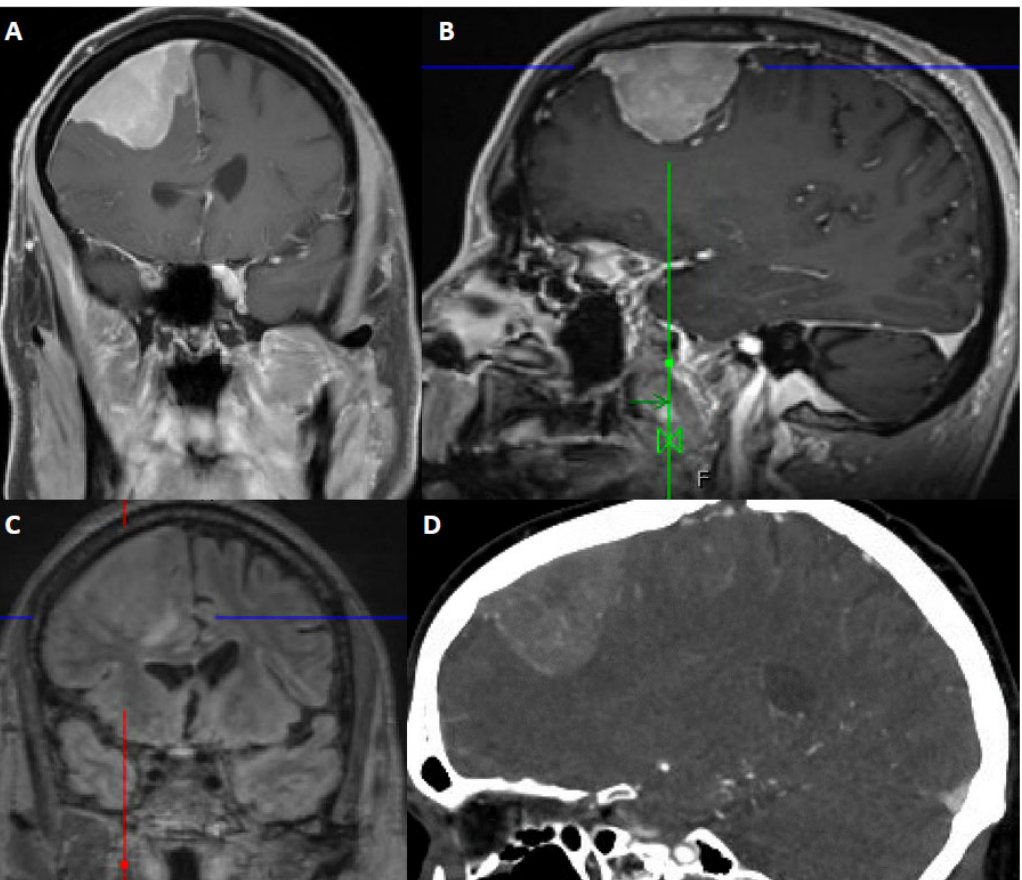
Figure 2. 67-year-old male presented with seizure and fall. After resection, pathology showed atypical meningioma, WHO grade 2. Molecular markers: TERT promoter wild type, positive for loss of chromosome 1p, 6, 14, 22, Y, segmental loss at 9p (haploinsufficiency of CDKN2A/B ). Patient underwent right middle meningeal artery embolization preoperatively. ( A ) Coronal contrast-enhanced T1-weighted image shows an avidly contrast-enhancing dural-based mass, dural thickening and enhancement, a slightly multilobular border, and moderate mass effect. ( B ) Sagittal contrast-enhanced Magnetization Prepared-RApid Gradient Echo (MPRAGE) shows a reactive dural tail. ( C ) Coronal 3D fluid attenuated inversion recovery (FLAIR) sequence shows associated vasogenic edema. ( D ) Sagittal CTA of the head demonstrates internal